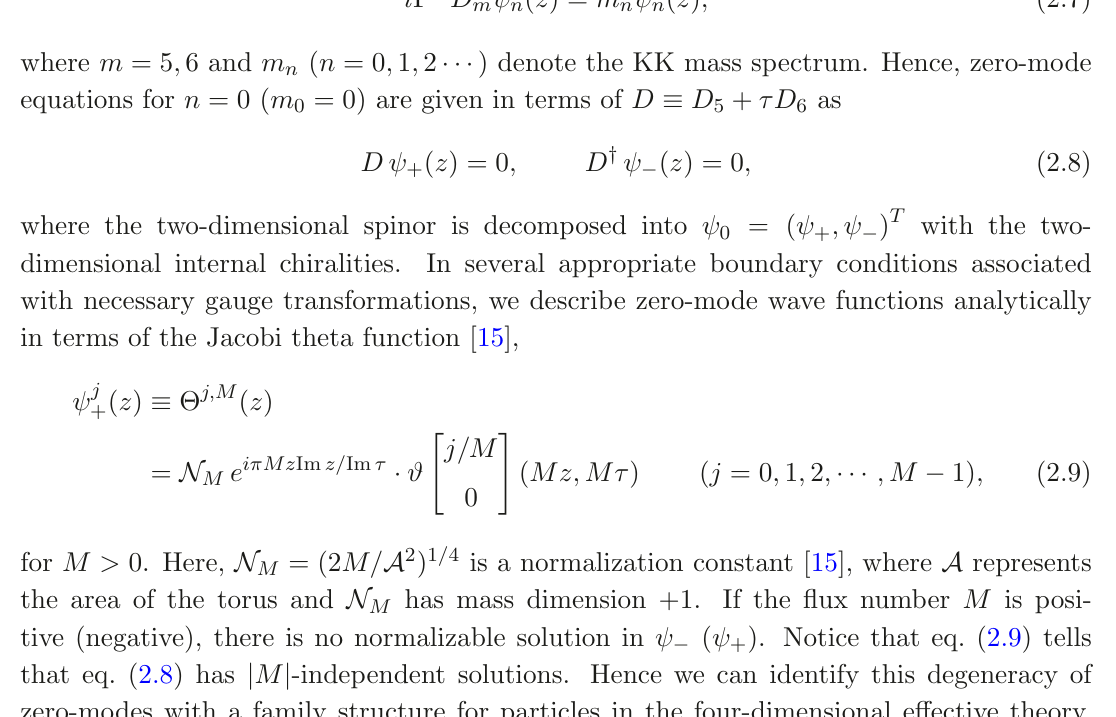
5 and y 6 is given as